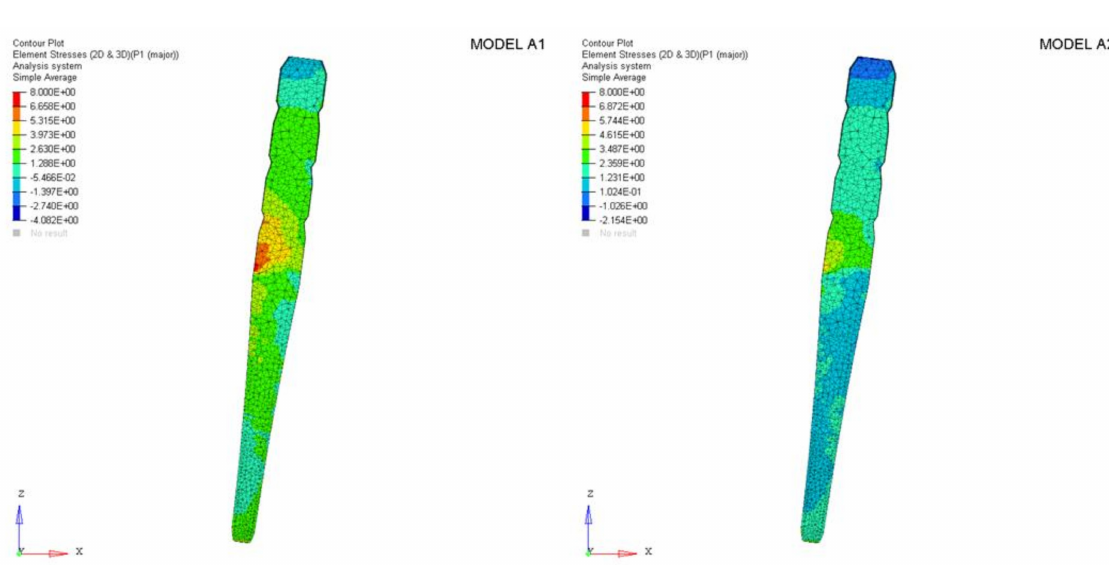
Figure 5. Models A1 and A2: Maximum principal stress distribution (MPa). The color scale was chosen to allow for comparison among the analyzed models.